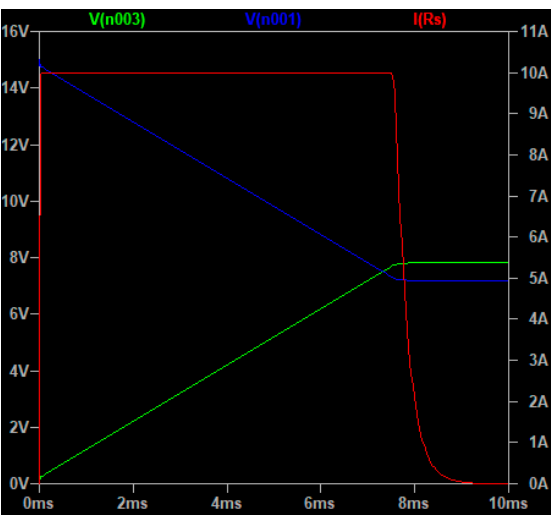
Figure 7. Time simulation for the discharge of C 1 and the charge of C 2 across the DUT. Current flow (red line), voltage of C 1 (blue line), and voltage of C 2 (green line) over time.